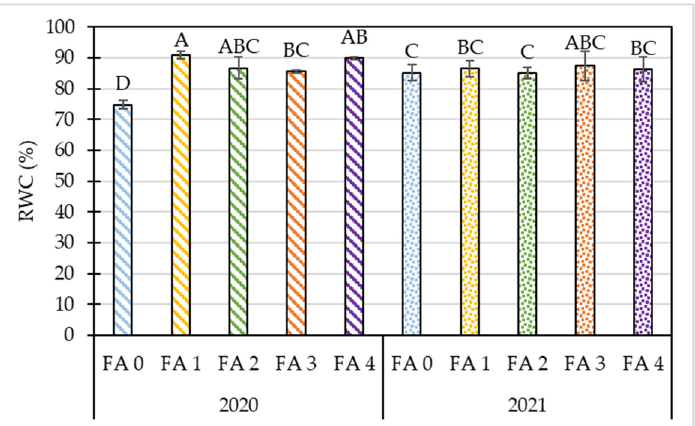
Figure 3. Influence of interaction Y × FA on relative water content (RWC). FA0: only water; FA1: 8 g L − 1 of CaO; FA2: 12 g L − 1 of CaO; FA3: 8 g L − 1 of CaO + 16 g L − 1 of urea; FA4: 12 g L − 1 of CaO + 16 g L − 1 of urea. Values with different letters are significantly different at p ≤ 0.05 according to Tukey’s test. Bars represent the standard